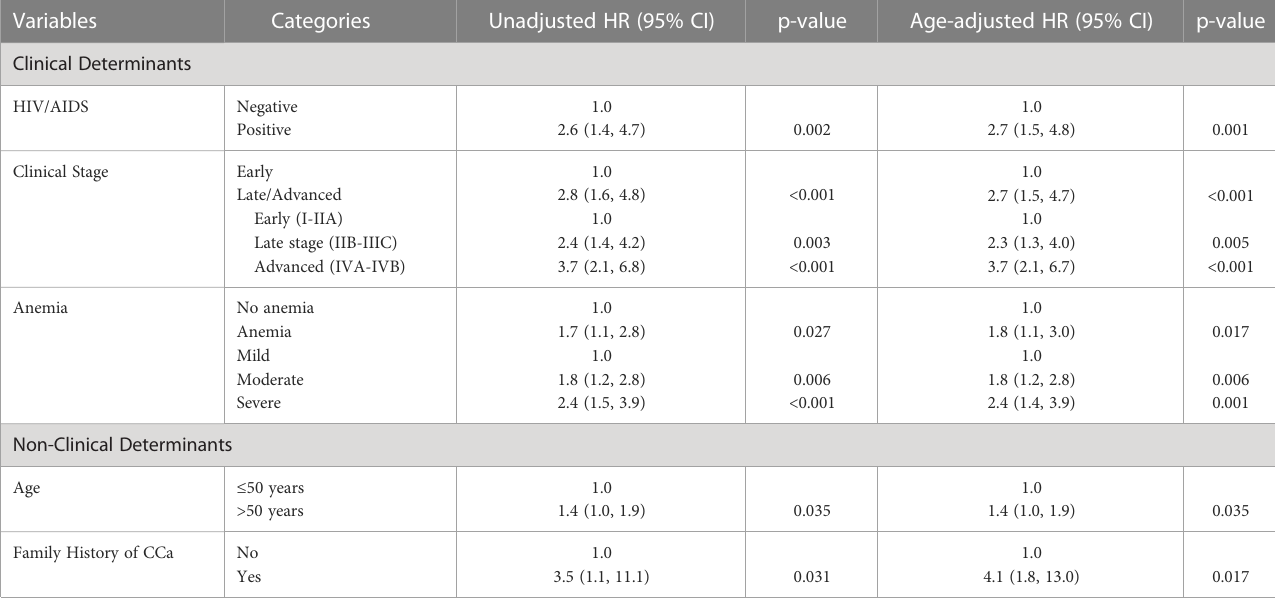
TABLE 3 Age-adjusted and unadjusted hazard ratios for CCa mortality.